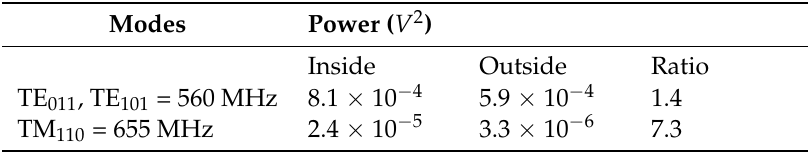
Table 5. Peak values for first TE and TM modes inside and outside the tank for internal PD in Nomex.